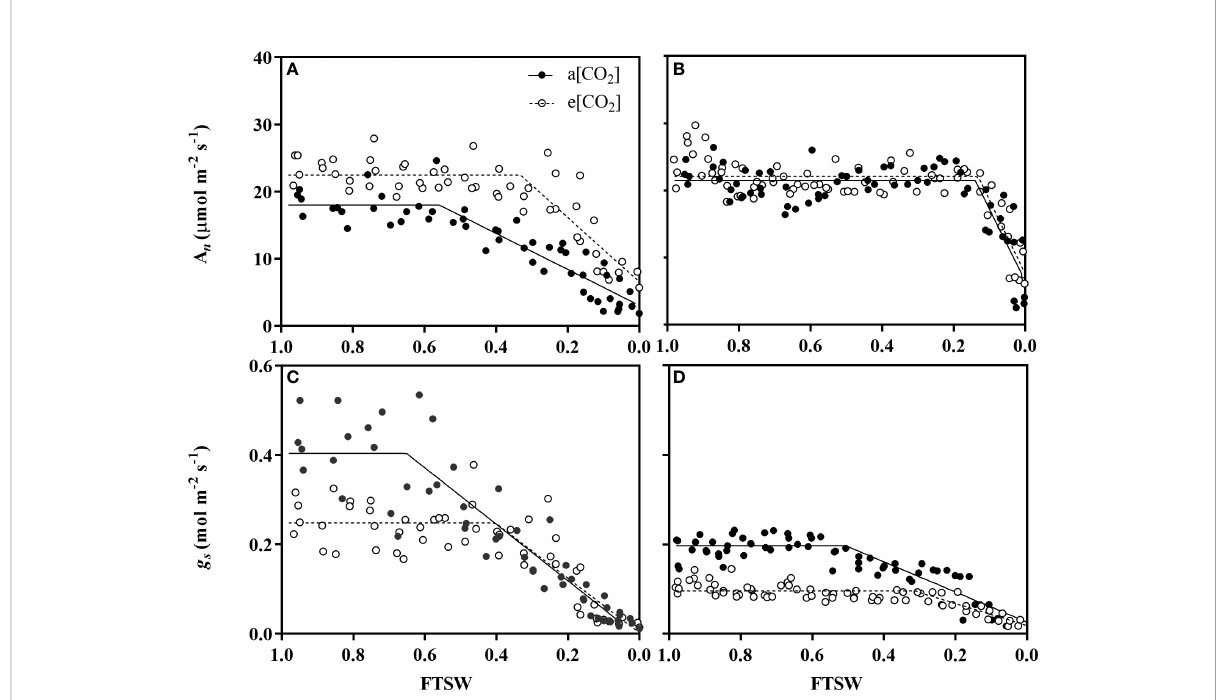
FIGURE 3 Changes of net photosynthesis rate (A n ) of (A) wheat and (B) maize plants and stomatal conductance ( g s ) of (C) wheat and (D) maize plants grown under ambient (400 ppm, a[CO 2 ]) and elevated (800 ppm, e[CO 2 ]) atmospheric CO 2 concentrations during progressive soil drying. Closed and open circles indicate plants at a[CO 2 ] and e[CO 2 ] concentration, respectively. Error bars indicate standard error of the means (SE) (n =